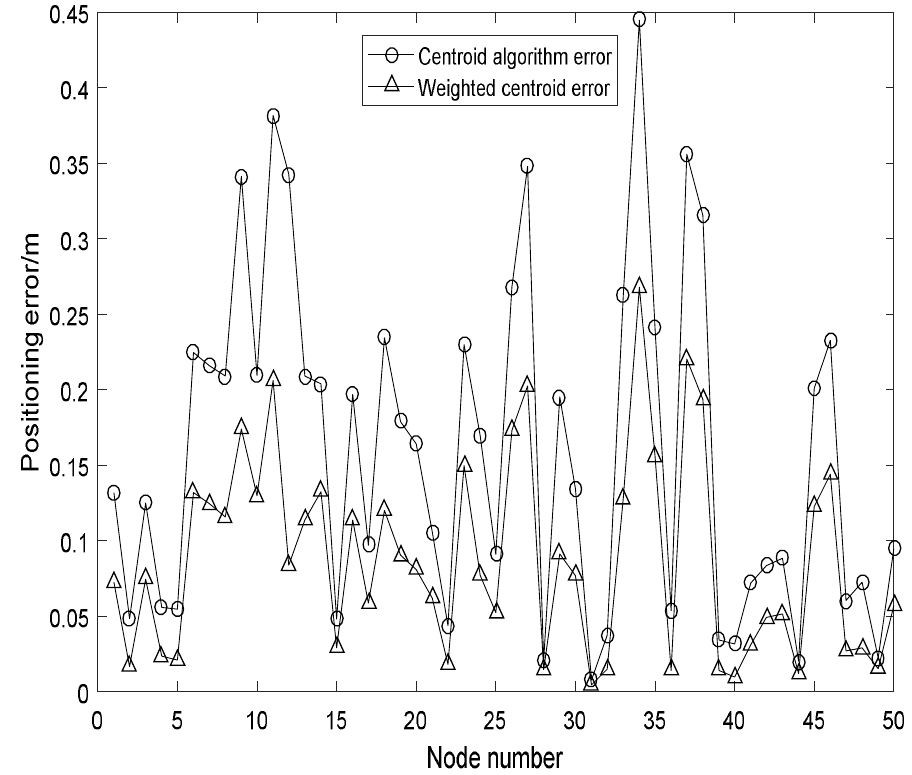
Figure 4. Location error comparison of WCA and Figure 4 . Location error comparison of WCA and CA.